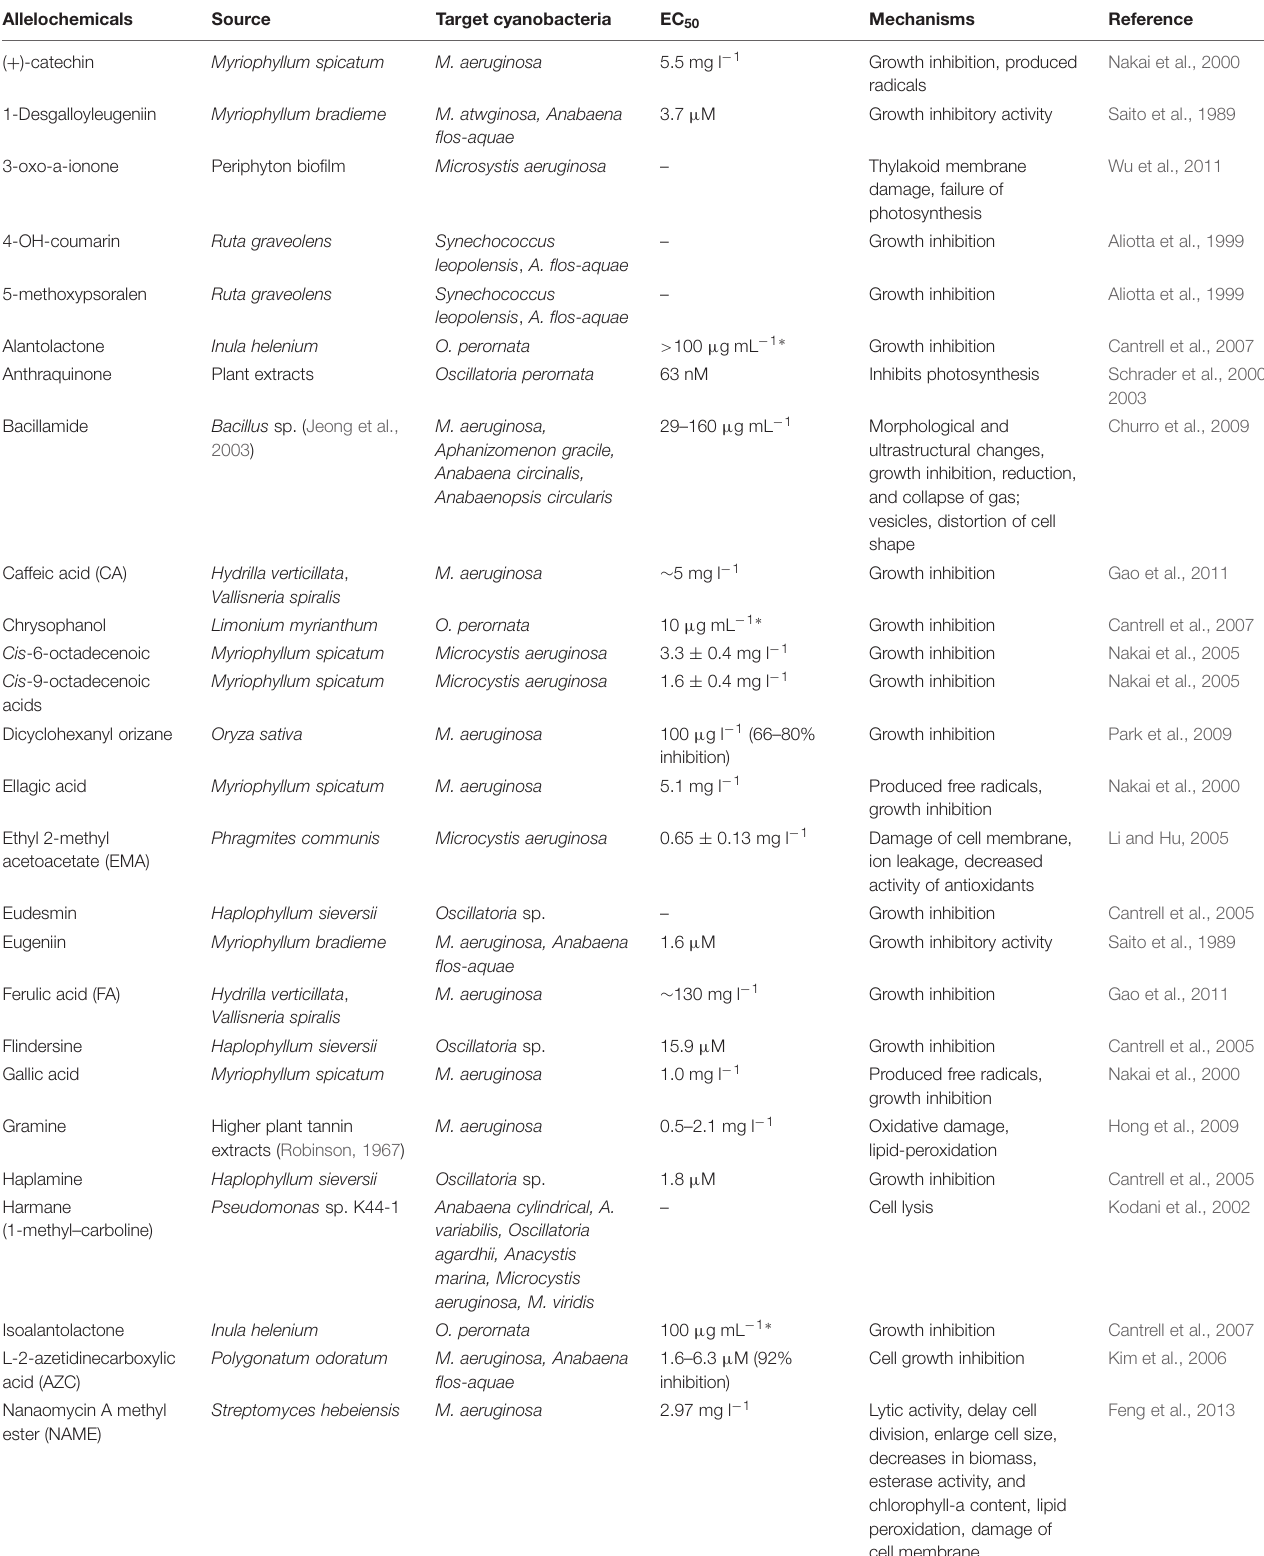
TABLE 2 | Allelochemicals and their inhibitory effects against some bloom forming cyanobacteria.